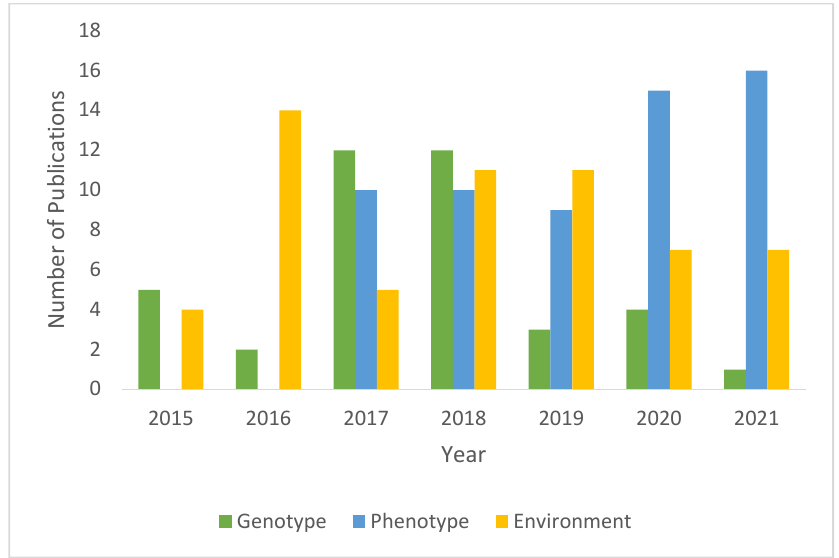
Figure 4. The trend of using categorical factors between 2015 and 2021.